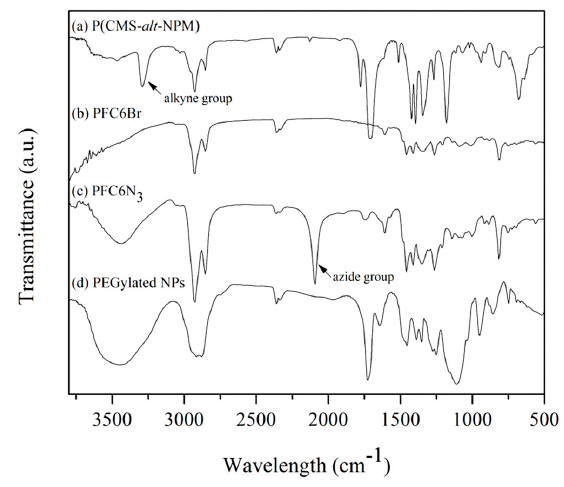
Figure 3. FTIR spectra of ( a ) P(CMS- alt -NPM)1, ( b ) PFC6Br, ( c ) PFC6N 3 and ( d ) the PEGylated fluorescent NPs.